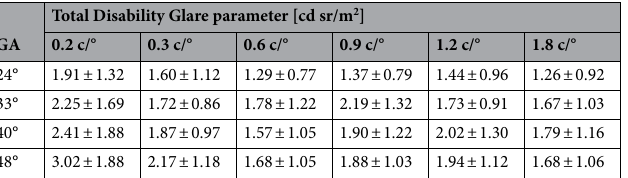
Table 1. Mean ± standard deviation in [cd m 2 ] of the TDG parameter for all spatial frequencies and angular sizes of the glare source.